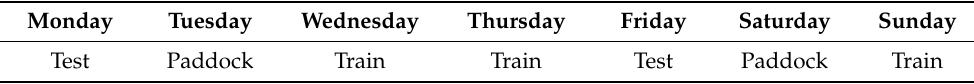
Table 1. Example of a weekly training program of the